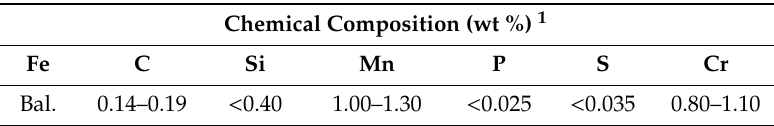
Table 1. Nominal composition of the case hardening steel